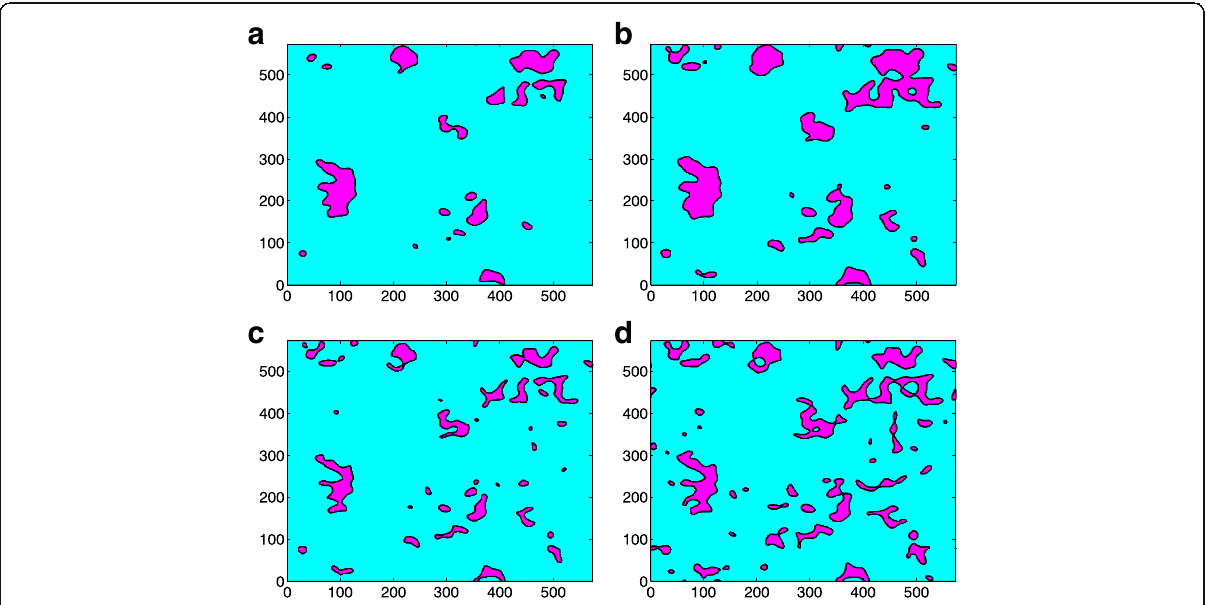
Fig. 6 The cluster distribution contour (in σ ) at different contact areas for the asperity model and GFMD model, respectively. a Asperity model with 5% contact area. b Asperity model with 10% contact area. c GFMD model with 5% contact area. d GFMD model with 10% contact area